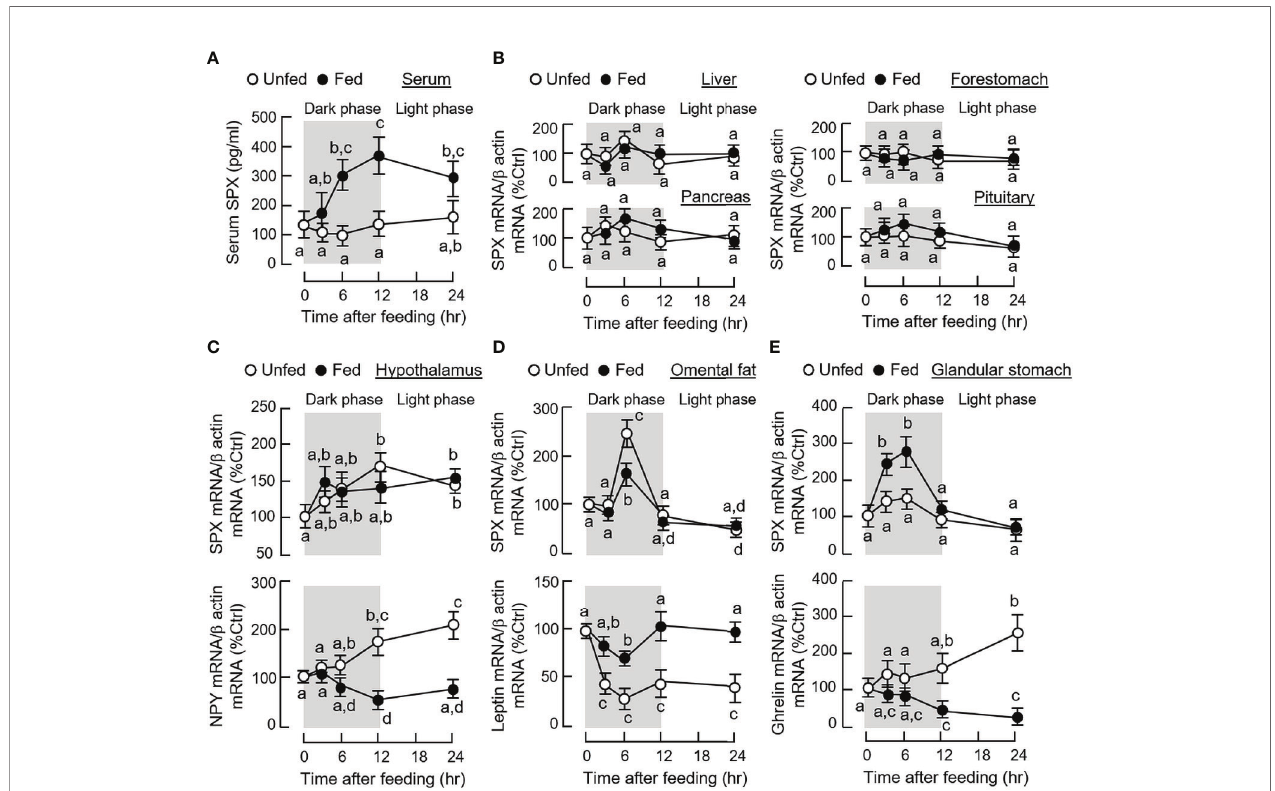
FIGURE 1 | Effects of food intake on SPX released into circulation and SPX gene expression at tissue level in mice. After acclimation to inverted photoperiod, one group of the mice was maintained under the scheduled feeding plan (as the “ fed ” group) while the other group did not receive the supply of chow pellets (as the “ unfed ” group). Serum samples and target tissues were harvested at the time points as indicated (with light off at 10:00 AM as time “ zero ” ). Time course of food intake on SPX released into circulation was examined by measuring SPX levels in serum samples using SPX ELISA (A) . The corresponding effects of food intake on SPX mRNA expression in target tissues, including the liver, pancreas, forestomach and pituitary, was quantitated by real-time PCR (B) . In selected tissues, including the hypothalamus (C) , omental fat (D) and glandular stomach (E) , besides SPX mRNA, parallel expression of NPY, leptin and ghrelin transcript levels in the respective tissues were also monitored to serve as positive control. For the data presented, the groups denoted by different letters represent a signi fi cant difference at p <